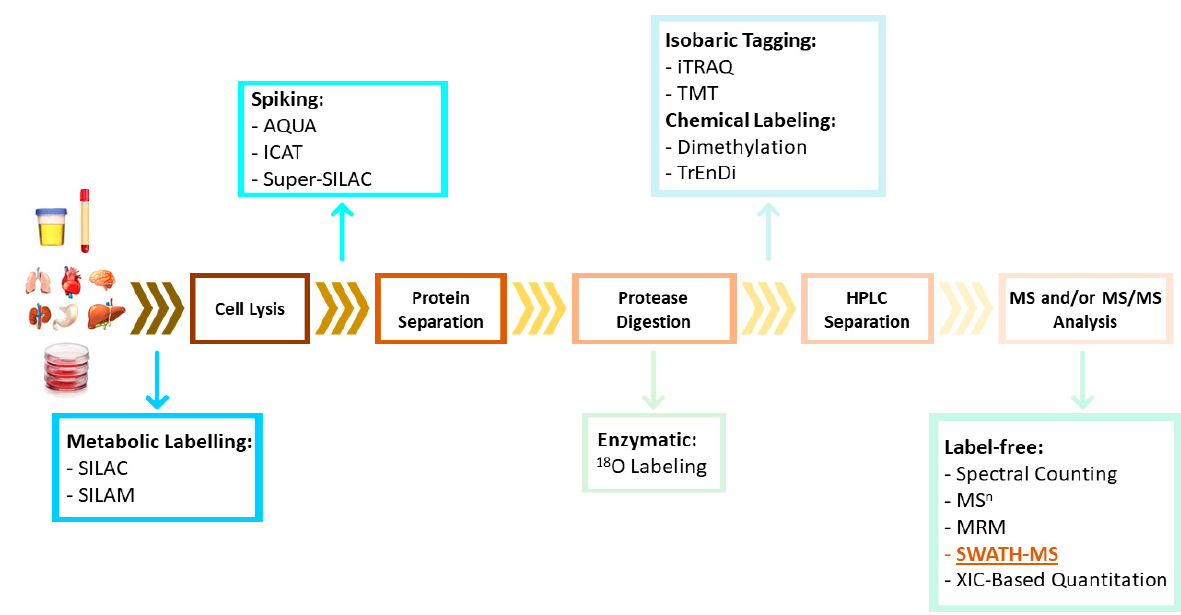
Figure 3. Quantitative methods for proteomics. A quantitative proteomics workflow involves protein extraction/preparation and digestion followed by LC-MS/MS analysis; therefore, there are multiple time points at which peptide quantitation strategies may be introduced. They can be included in cell culture or animal model samples that can be labeled metabolically at the protein level. After cell lysis or protein purification (in clinical samples), labeled proteins can be spiked. During enzymatic digestion, enzymatic labeling can be performed using 18 O. After digestion, peptides can be labeled chemically or isobarically. Finally, label-free techniques can be used: in these cases labeling of samples is not required, and quantitation is performed during or after data